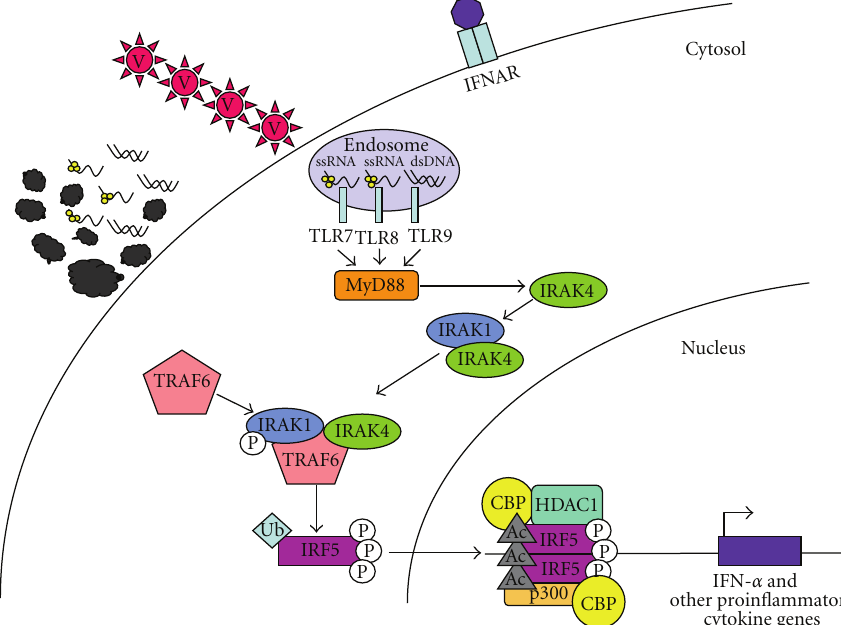
Figure 1: Schematic model forIRF5 activation. Cells use TLRs as sensors to detect the presence of viruses (V) via TLR7, -8, and -9. Alternatively, apoptotic debris (shown here as membrane blebs, ssRNA, and dsDNA) can also be a source of nuclear proteins and nucleic acids. Nuclear material is brought to the endosome, triggering TLR7, -8, and -9 signaling. Binding of cognate ligands to these TLRs recruits MyD88, a main signaling intermediate involved in TLR7, -8, and -9 signaling. MyD88 recruits interleukin-1 receptor associated kinase (IRAK)-4. IRAK-4 binds and phosphorylates IRAK-1, which in turn recruits Tumor necrosis factor (TNF) receptor associated factor (TRAF) 6 [46–48]. TRAF6 is an E3 ubiquitin (Ub) ligase that adds K63-Ub chains to IRF5 [49]. IRF5 is then shuttled to the nucleus and is acetylated by CBP and p300 [50]. Together, these events set the stage for the transcription of IFN- α and other pro-inflammatory cytokine